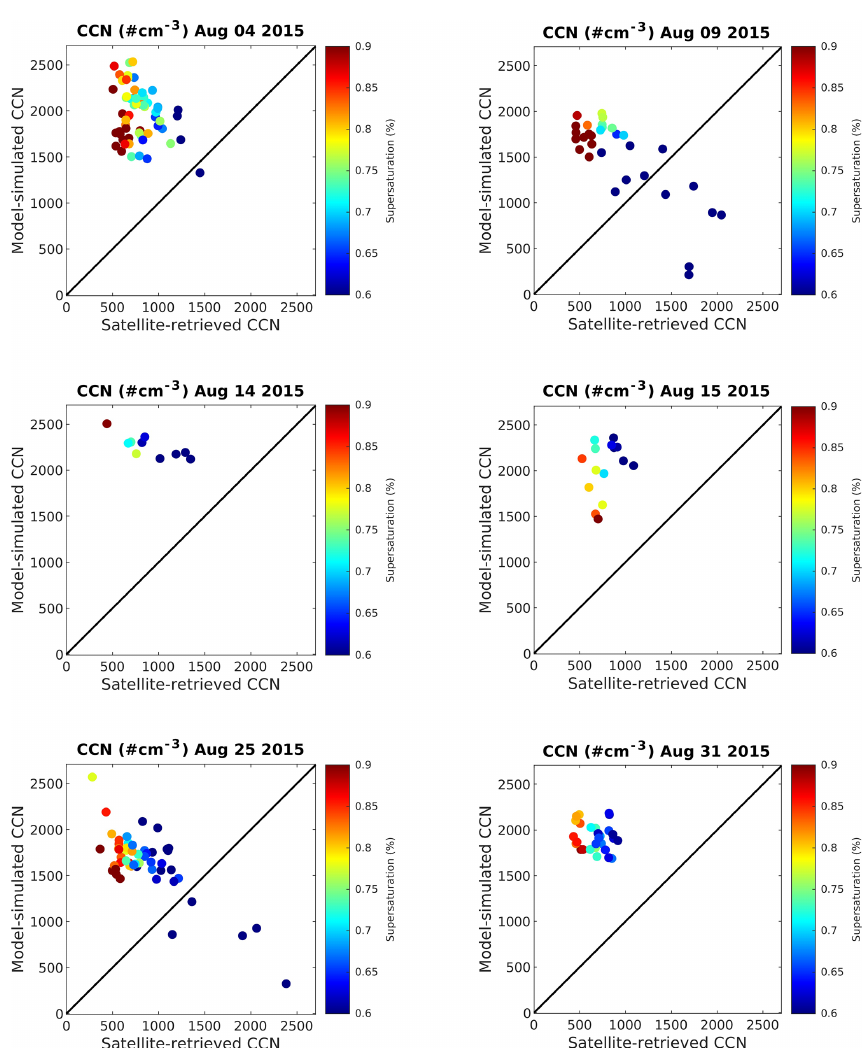
Figure 8. Model-simulated vs. VIIRS satellite-retrieved CCN number concentrations for 6d of available data within the study domain during the August 2015 study period. The data points represent CCN number concentrations at the cloud base of existing convective cells on different days over the study domain